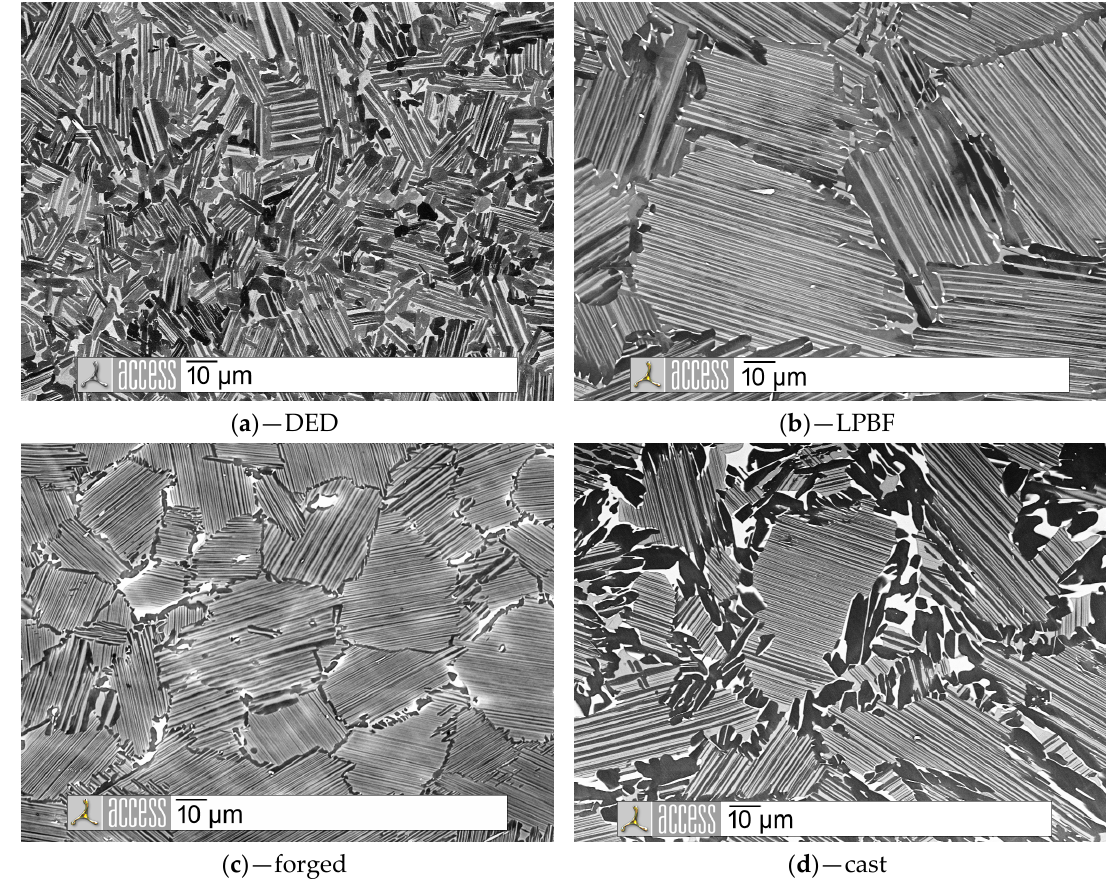
Figure 1. SEM images of heat-treated TNM ( a ) manufactured by DED; ( b ) manufactured by LPBF [32]; ( c ) manufactured by forging; ( d ) manufactured by casting.